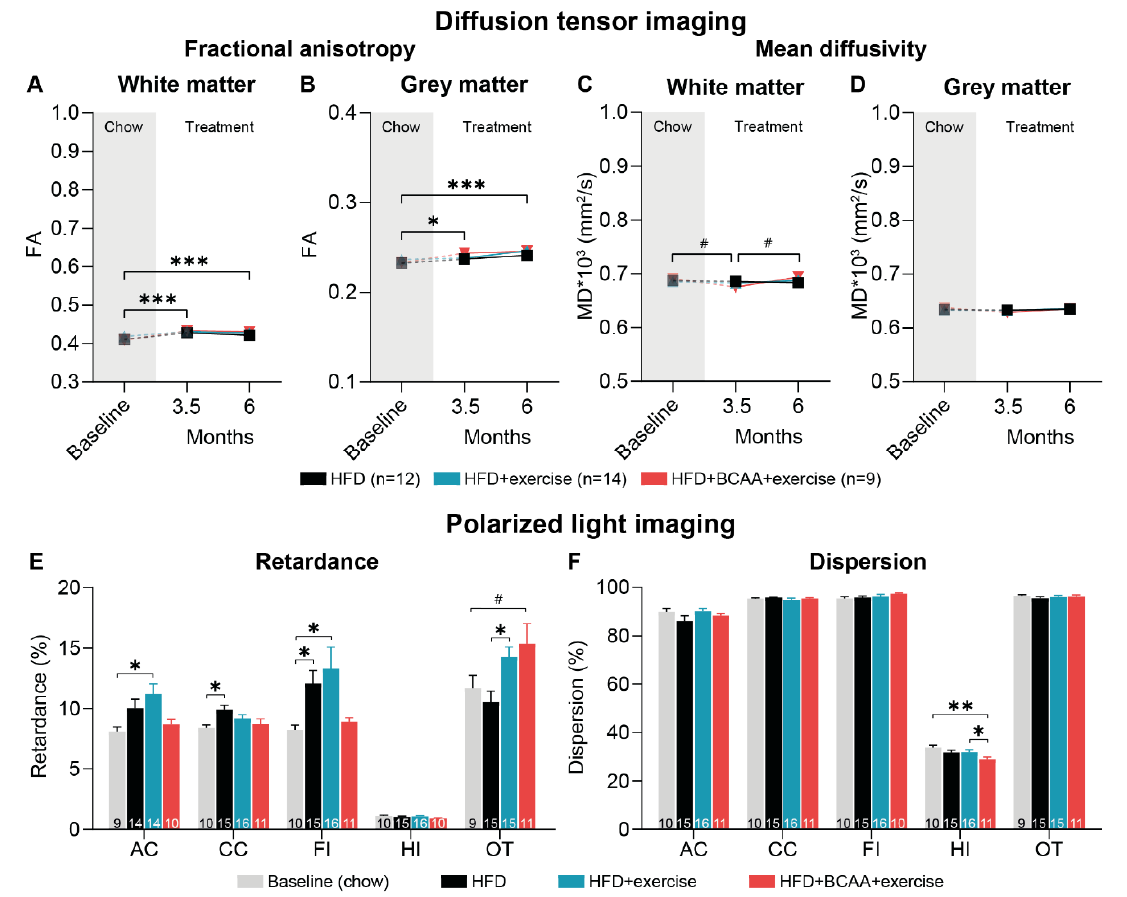
Figure 10. Grey matter and white matter integrity. Diffusion tensor imaging was performed in vivo to investigate grey and white matter integrity of HFD, HFD + exercise, and HFD + BCAA + exercise animals at baseline (chow) and after 3.5 and 6 months of treatment. Fractional anisotropy (FA) and mean diffusivity (MD) were assessed in ( A , C ) white matter and ( B , D ) grey matter. Additionally, polarized light imaging (PLI) was performed post mortem to quantify myelin density, based on the ( E ) retardance map, as well as fiber orientation, based on the ( F ) dispersion map, in different brain regions, including the anterior commissure (AC), corpus callosum (CC), fimbria (FI), hippocampus (HI), and optic tract (OT). Group differences between young chow-fed animals (baseline), HFD, HFD + exercise, and HFD + BCAA + exercise animals were analyzed. High-fat diet (HFD), branched- chain amino acids (BCAA). Data are presented as mean ± SEM. * p < 0.05, ** p < 0.01, *** p < 0.001, # 0.05 < p < 0.08 (trend).